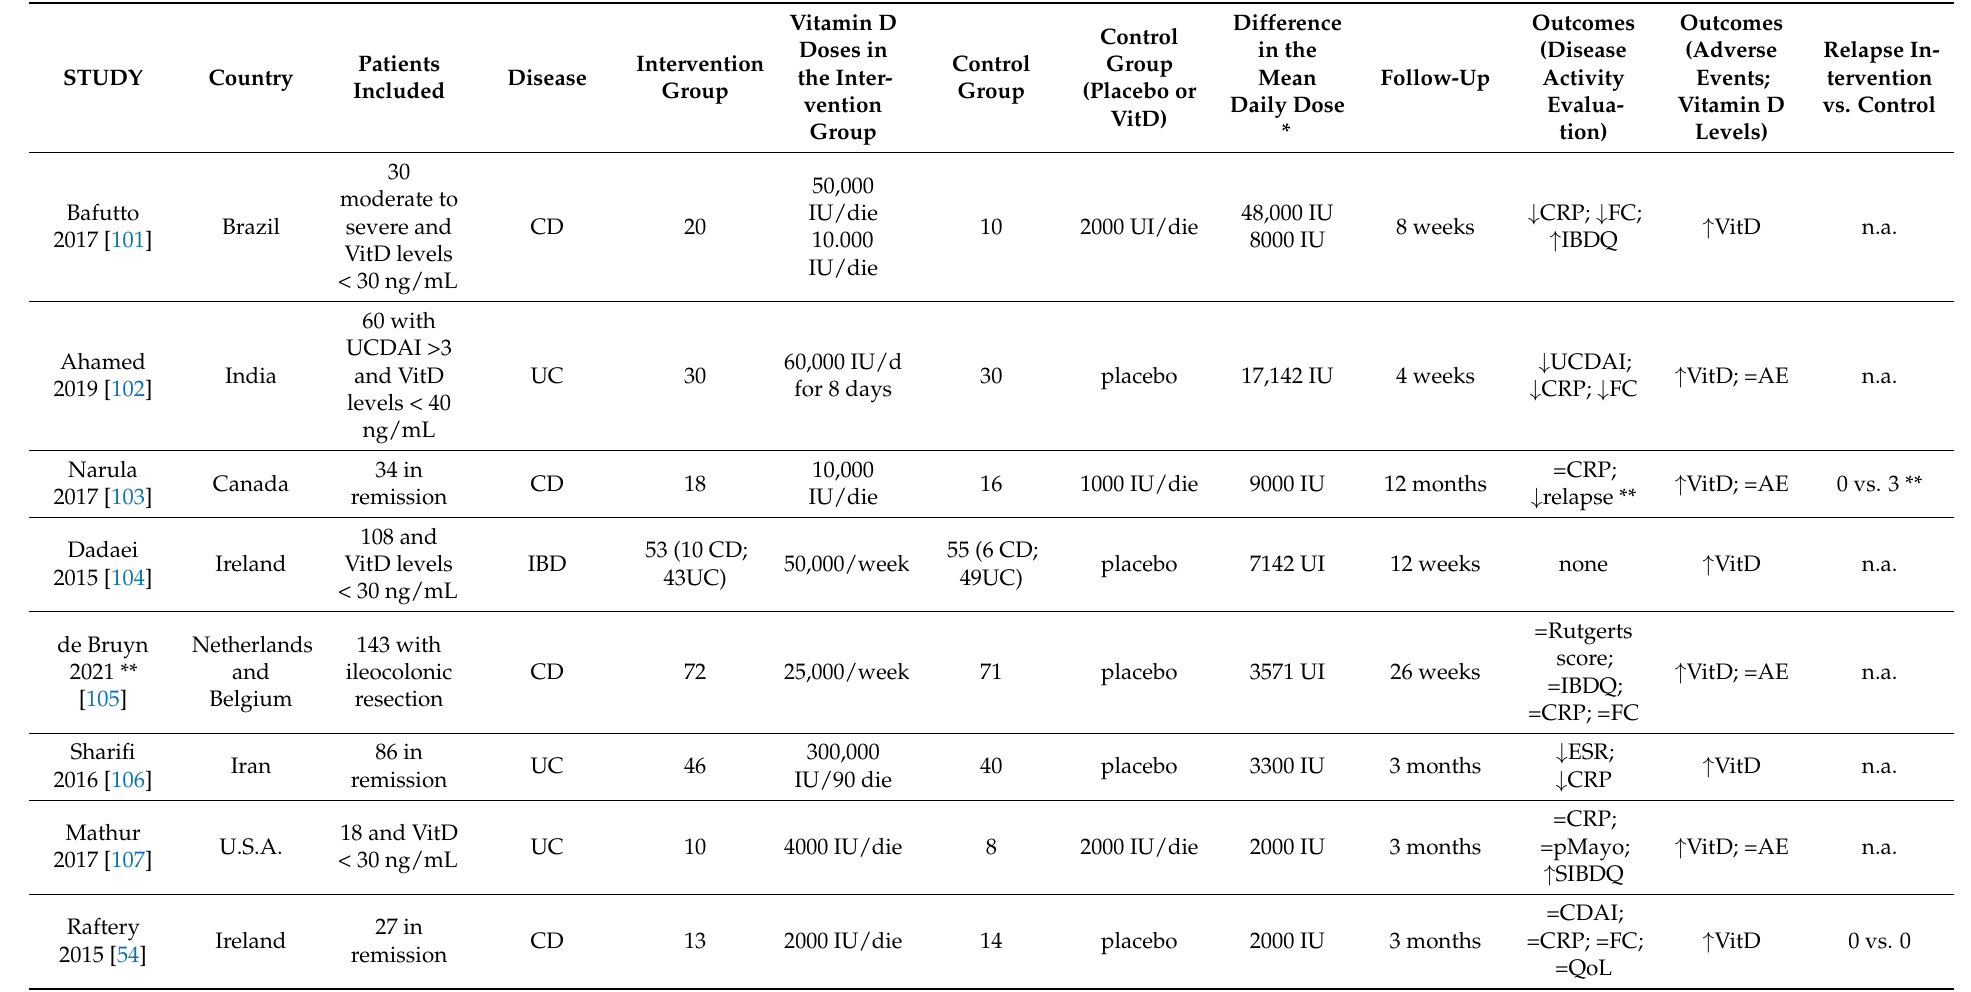
Table 1. RCTs evaluating vitamin D supplementation on IBD and clinical